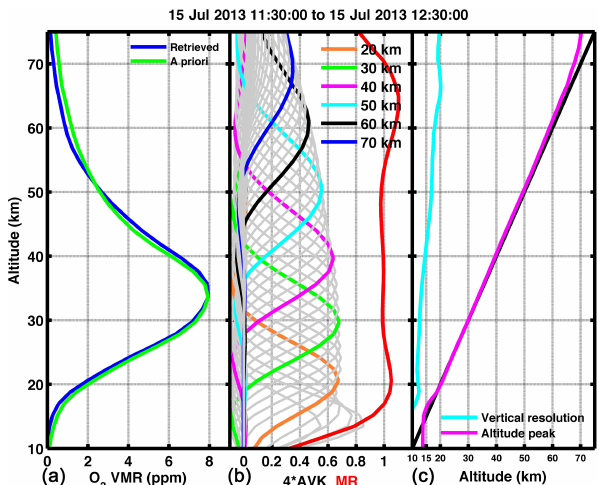
Figure 2. Example of an a priori profile and a retrieved ozone profile (green and blue lines in panel (a) , respectively), averaging kernels (grey and coloured lines in panel (b) ), the measurement response (red line in the panel), vertical resolution (cyan line in panel (c) ), and altitude peak (magenta line in panel (c) ) of the GROMOS re- trieval version 150 for 15 July 2013 with an integration time of